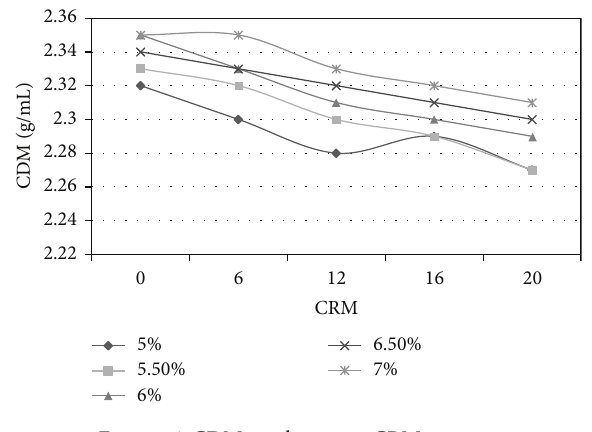
Figure 6: CDM results versus CRM content. Table 7: CDM results (g/mL) for different CRM contents.